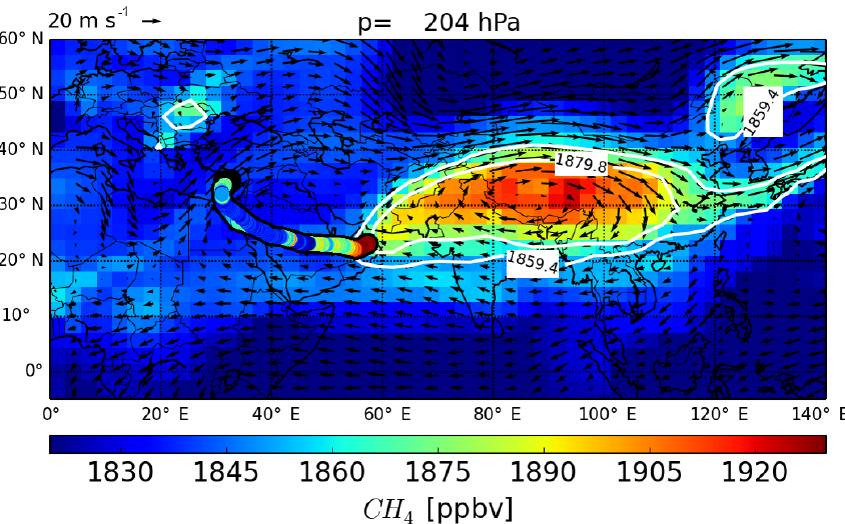
Figure 7. EMAC modelled CH 4 and wind field; daily means at 204hPa, and in situ CH 4 (above 300hPa) along the flight track for flight 19 (13 August 2015). White contours represent the CH 4 threshold and background values according to Sect. 3.1.